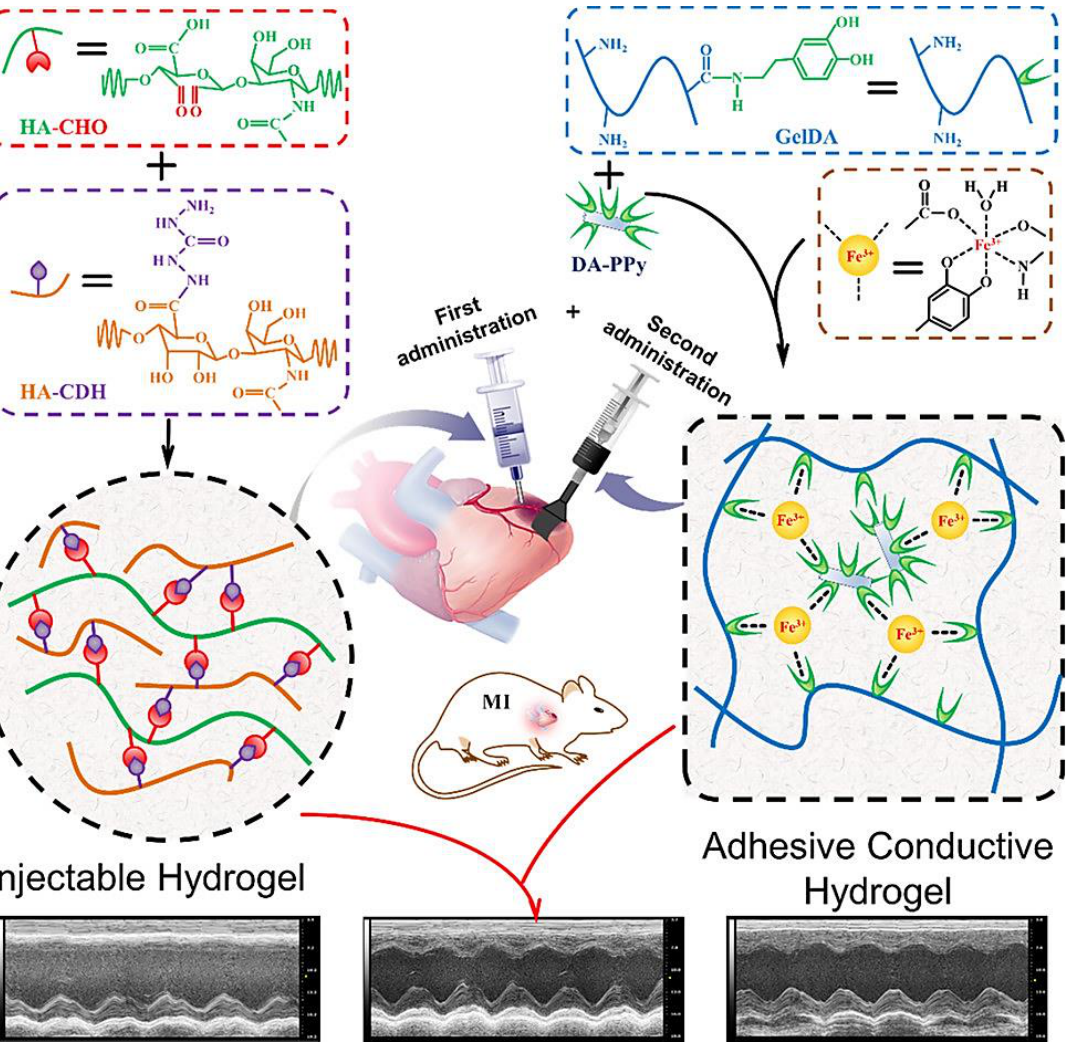
Figure 2. The design of an injectable hydrogel and adhesive hydrogel patch, as well as the combined internal–external treatment strategy for MI. HA-CHO: oxidized sodium hyaluronic acid; HHA: hy- drazided hyaluronic acid; GelDA: dopamine-gelatin; DA–PPy: dopamine-functionalized polypyr- role. Adapted from Ref. [62] with permission. Copyright 2019 American Chemical Society.